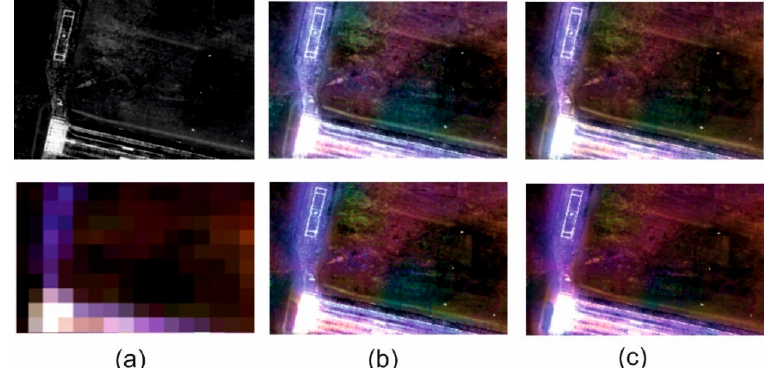
Figure 12. ( a ) Original panchromatic WorldView-2 image and multispectral Landsat 8 OLI image. ( b ) Results of data fusion using the classical approach (above) and modified approach (below) after GIHS fusion. ( c ) Results of data fusion using the classical approach (above) and modified approach (below) after GIHS-BT fusion for open area.